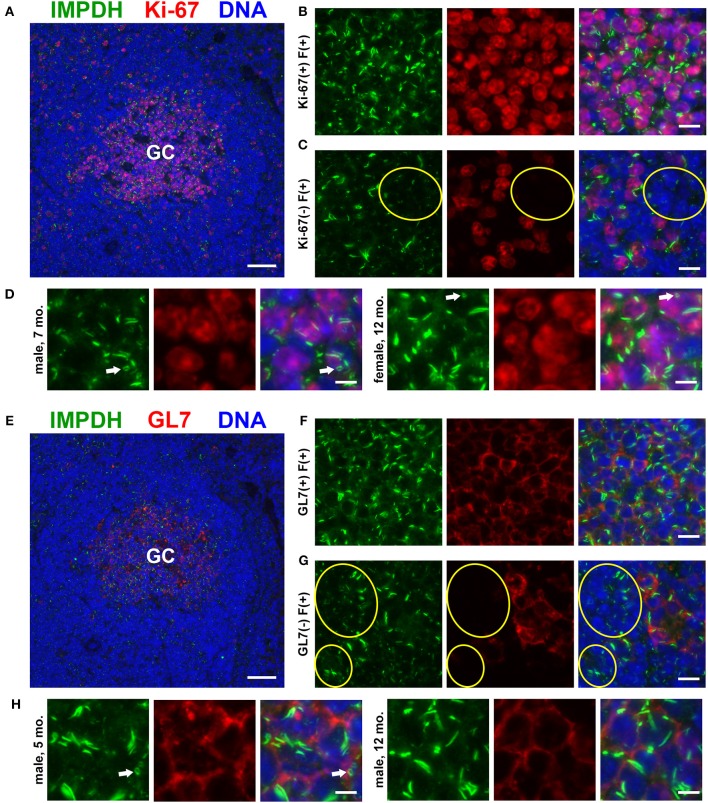
Proliferating cells in germinal centers form IMPDH filaments in vivo. (A) Representative image of a germinal center in an FFPE spleen section from an adult healthy B6 mouse stained for IMPDH (green) and proliferation marker Ki-67 (red). (B) Representative image of Ki-67-positive cells in GCs forming abundant IMPDH filaments. (C) Representative image showing that IMPDH filament formation was also commonly observed in Ki-67-negative cells (highlighted by yellow circles). (D) Representative images of two different mice, a 7-months-old male and a 12-months-old female. Images were captured using the same objective as (B,C) but were enlarged 2× to more clearly show IMPDH filaments within proliferating cells. White arrows: ring structures. (E) Serial section depicting the same GC as in (A), but stained instead for IMPDH (green) and GC marker GL7 (red). (F) Representative image of extensive IMPDH filament formation by GL7+ cells. (G) Representative image showing that IMPDH filaments also form in GL7− cells (marked by yellow circles). (H) Representative images of two different mice, a 5-months-old male and a 12-months-old male. Images were captured using the same objective as (F,G) but were enlarged2 × to more clearly show IMPDH filaments within GC cells. White arrows: ring structure. Counterstain for all panels: DAPI (blue). Scale bars: 50 μm (A,E), 10 μm (B,C,F,G), 5 μm (D,H).